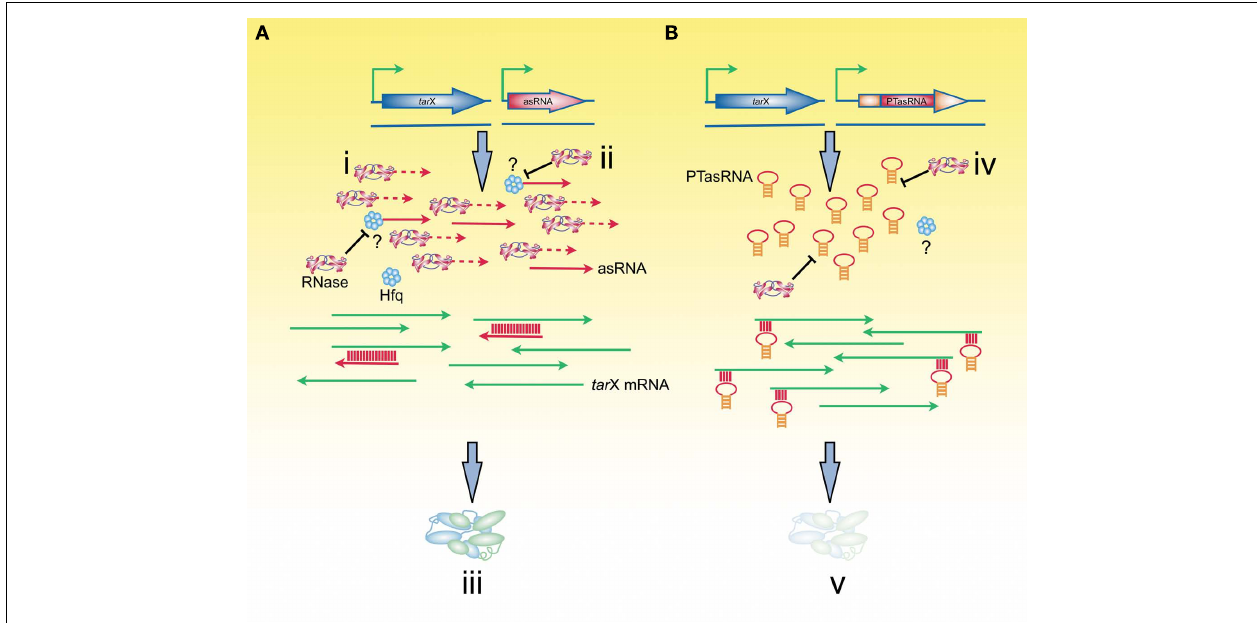
In situations where the abundance and stability of the linear asRNA is low, only partial gene silencing will result (iii). (B) Addition of paired-termini to the asRNA results in asRNAs that have increased abundance, likely as a result of resistance to RNase degradation (iv).The role of Hfq in PTasRNA-mediated gene silencing is unclear.The increased abundance of PTasRNAs results in a higher level of gene silencing